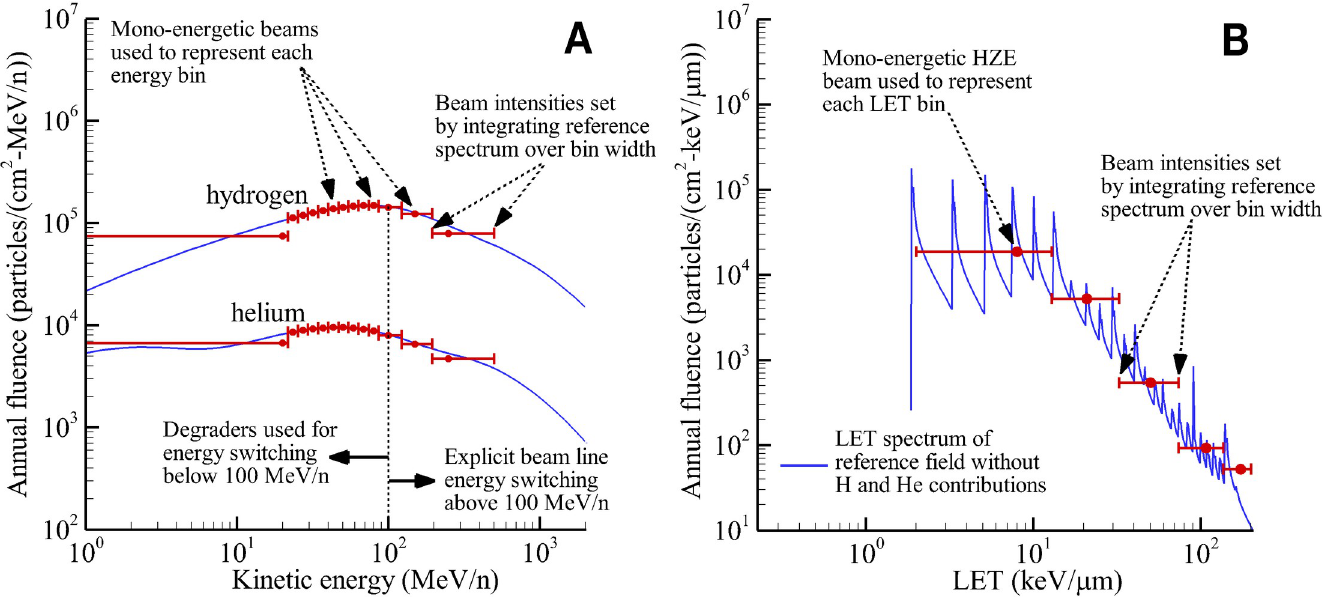
Fig 8. Representation of the reference field using discrete monoenergetic beams. The hydrogen and helium energy spectra are considered directly (A), whereas HZE ions are represented within the LET spectrum (B). Solid blue lines are the reference spectra from Fig 6. The bin widths for 1 GeV/n protons and helium particles are at lower fluences and not shown on the figure; however, these data are included in supplementary data file. All plot data available in S1 Data. HZE, high charge and high energy ions; LET, linear energy transfer.